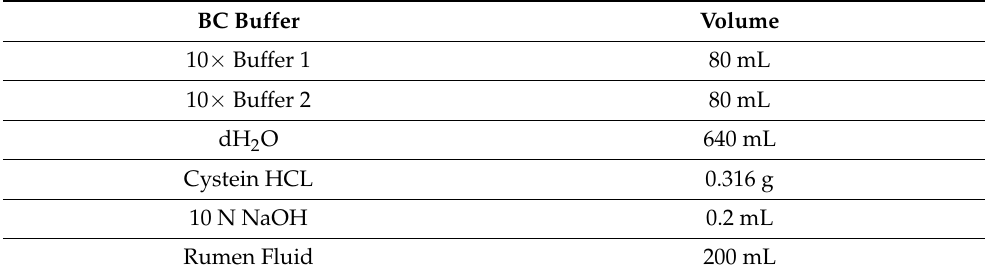
Table 1. The quantity of each compound used in one litre of